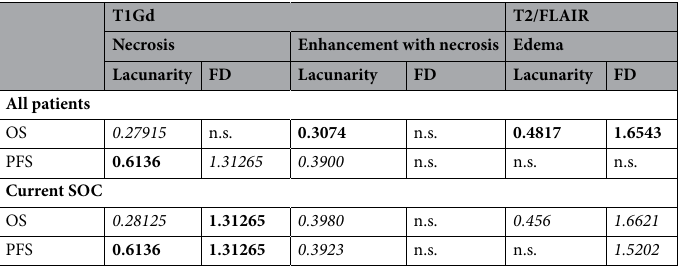
Table 2. Median lacunarity and fractal dimension (FD) tests that showed at least one significant cutoff that distinguishes survival. We show both overall survival (OS) and progression free survival (PFS) with those that were significant (unadjusted p < 0.05) in italics. The results that remained significant while adjusting for multiple comparisons are shown in bold (adjusted p < 0.05). The numerical value in the cell represents the optimal threshold of analyses that reached a level of significance. Results that did not show significance are indicated by "n.s" to represent "not significant".